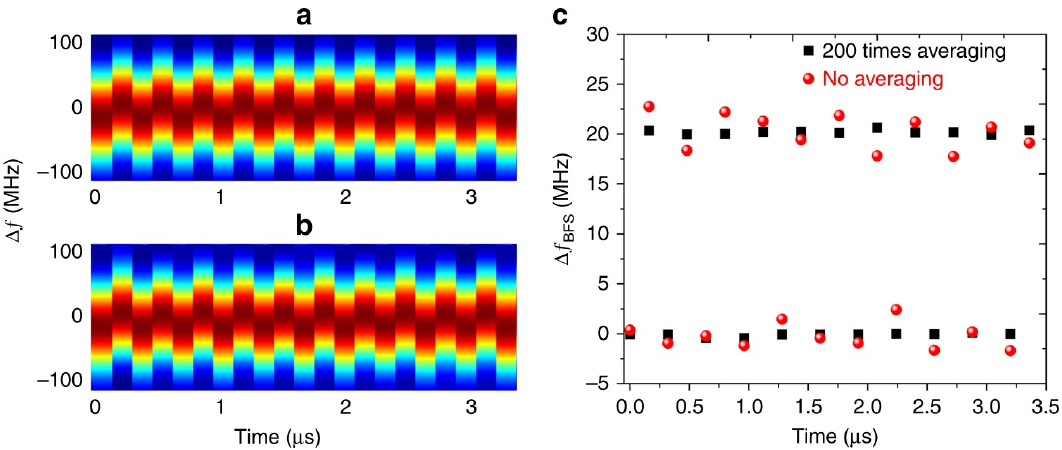
Figure 25. Time evolution of the BGS acquired over a 10-m long fiber for ( a ) averaging 200 times and ( b ) no averaging, where the BFS variation is simulated by periodically switching the probe frequency-sweep range. ( c ) Corresponding BFS evolution over time, with and without averaging [70].